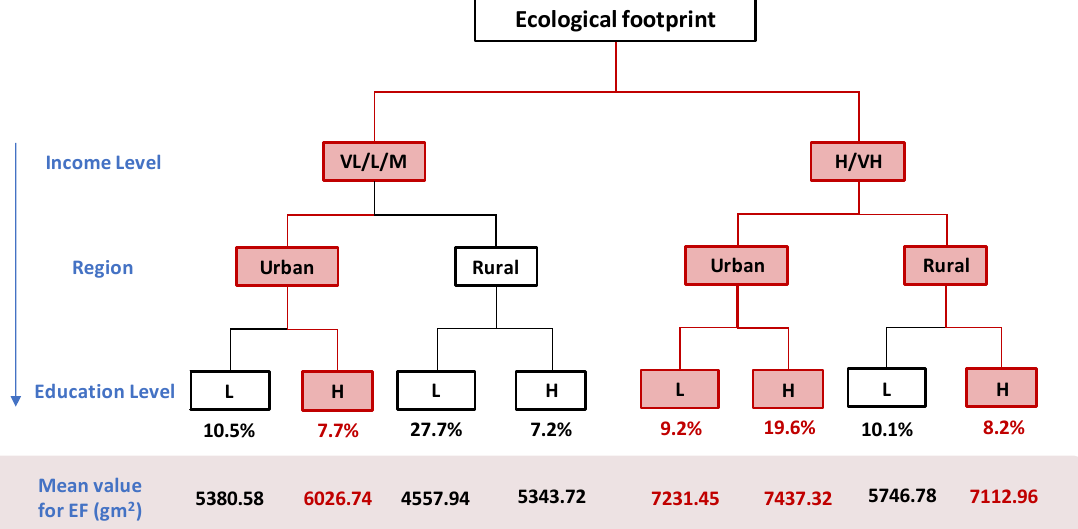
Figure 7. A decision tree for judgment of the ecological footprint consumption tendency where the red color indicates a high consumption tendency. The percentage under the decision tree represents the percentage of the number of samples under the category to the total number of samples. The real number indicates the average carbon footprint of 8 groups of people (gm 2 per year). For income level, VL, L and M mean very low, low and middle income level respectively, while H and VH mean high and very high income level. For education level, L and H mean low and high education level